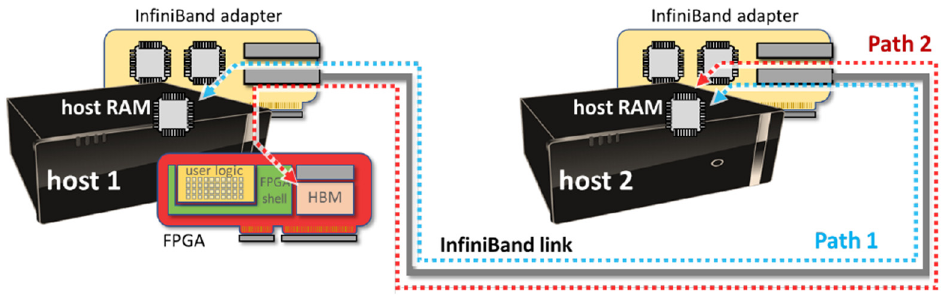
Figure 1. Schematic of the baseline system. The dashed arrows indicate the communication paths exercised in our experimental evaluation.